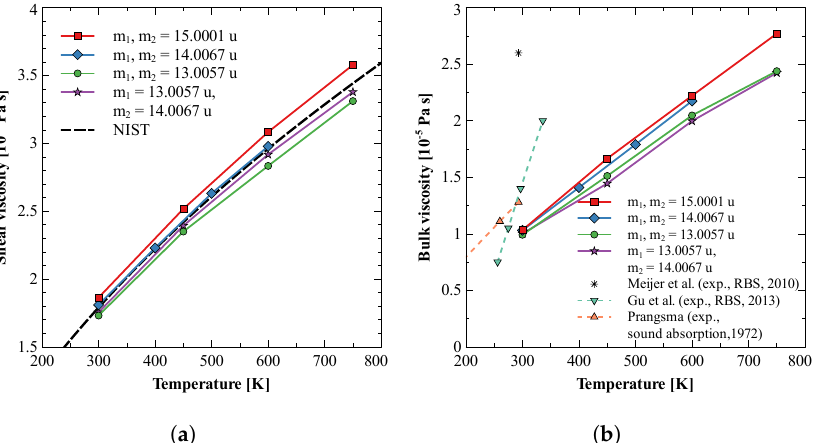
Figure 1. Bulk and shear viscosity of different isotopes of nitrogen gas. Here, m 1 and m 2 are masses of two atoms of the nitrogen molecule